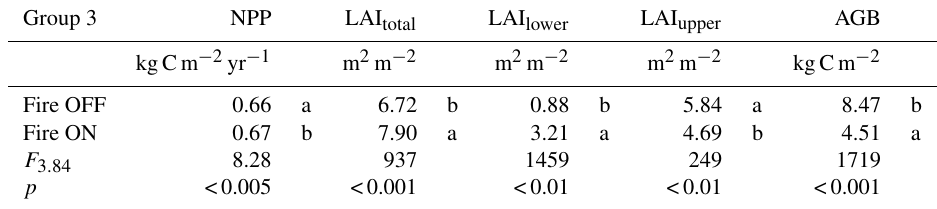
Table 5. Summary of average NPP, LAI and AGB for the Amazon–Cerrado transition zone over the transect domains, considering presence or absence of fire. One-way ANOVA results are also shown, including F statistics and p values. Values within each column followed by a different letter differ significantly ( p <0.05) according to the Tukey–Kramer test ( n = 1860: 31 pixels × 10 years × n simulation /2).